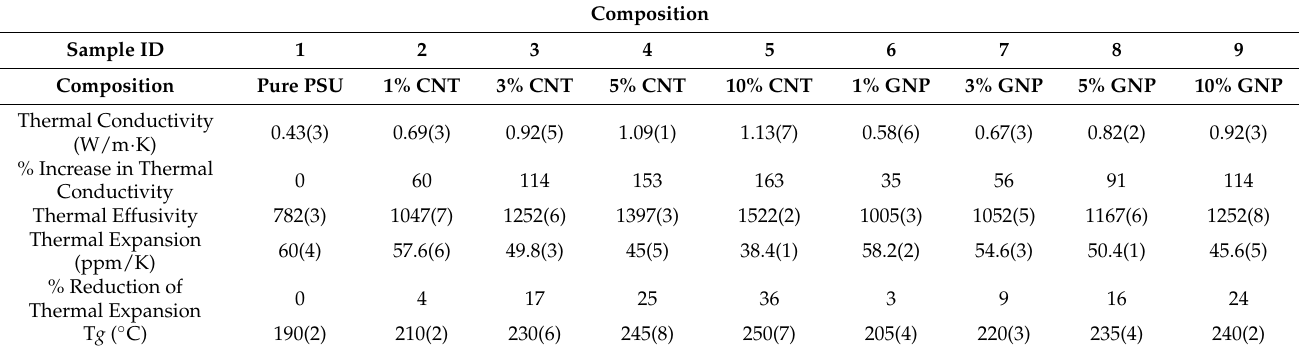
Table 2. Thermal properties of PSU-CNT and PSU-GNP composite samples; the sample IDs are according to Table 1.